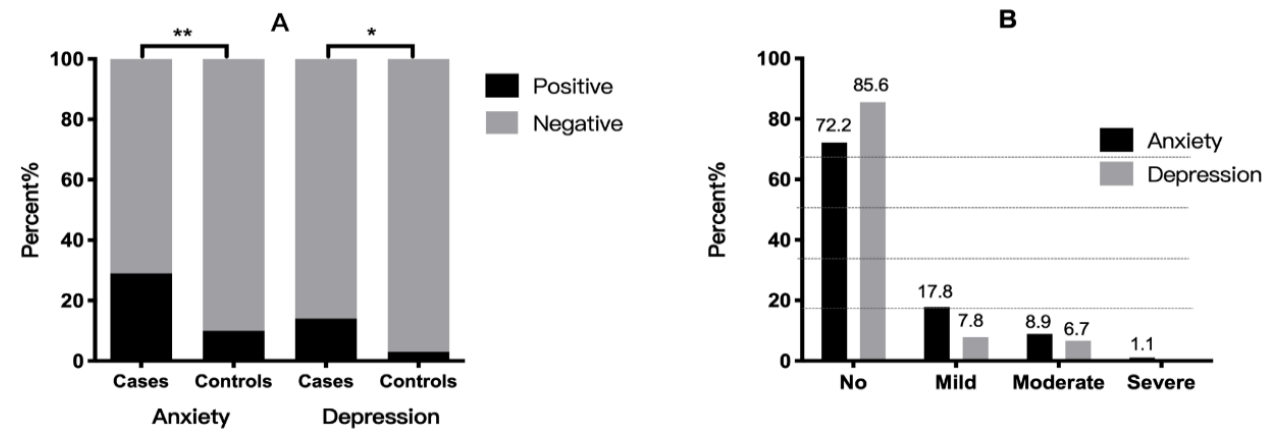
Figure 2. ( A ): Distribution of anxiety and depression. * p < 0.05, ** p < 0.01. ( B ): Severity of anxiety and depression in patients with adenomyosis.